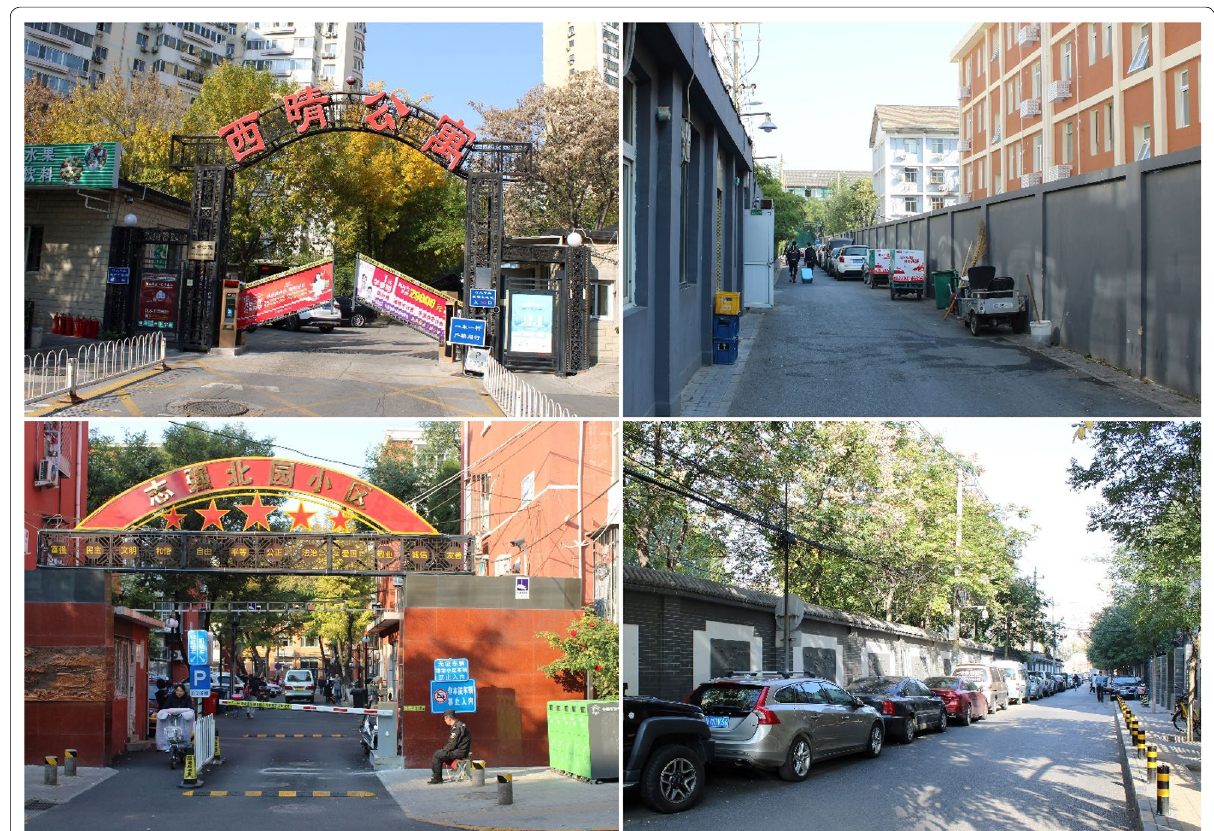
Fig. 3 Gates and walls of some residential neighborhoods in Beijing (Photo Credit: author,